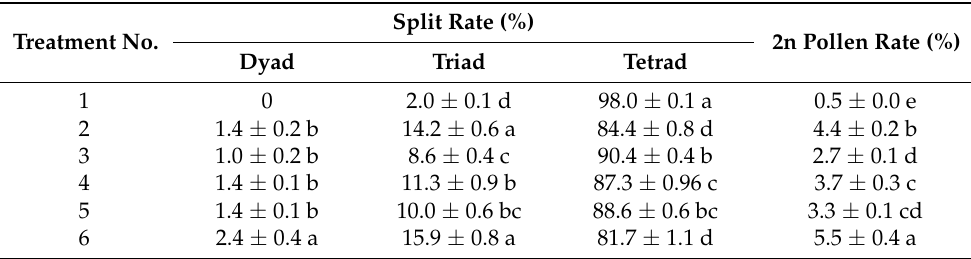
Table 3. The 2n pollen rate in various treatments estimated based on observation of abnormal split ratio in the tetrad